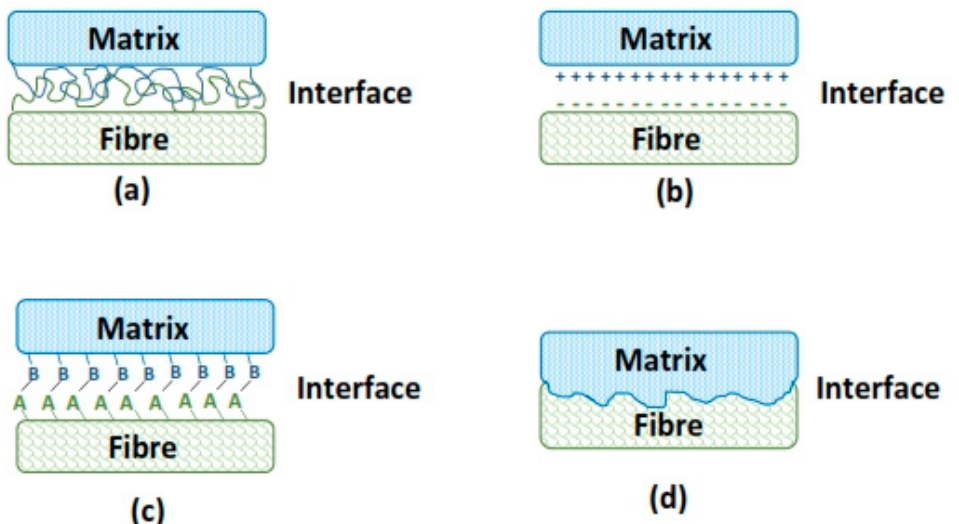
Figure 4. Fiber matrix interface bonding mechanisms. ( a ) Interdiffusion; ( b ) electrostatic adhesion; ( c ) chemical bonding; ( d ) mechanical interlocking. Open access under terms and conditions of the Creative Commons Attribution (CC BY), reference [69].